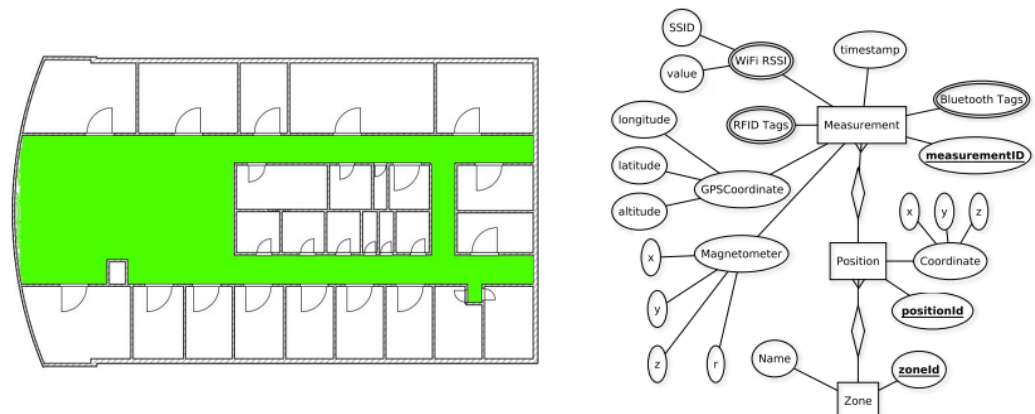
Figure 17. The area for the data collection and the schema of the database. Greed color shows the covered area for the data collection [53].